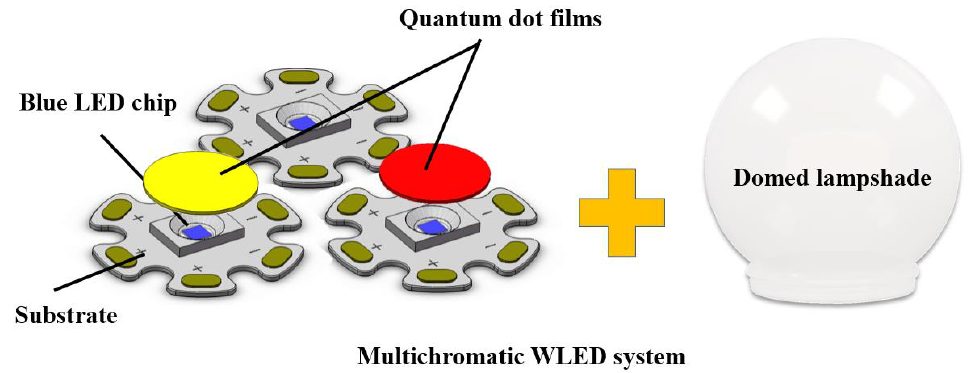
Figure 2. Assembly of the trichromatic WLED with three blue LED chips and two species of InP QDs with different peak wavelengths.